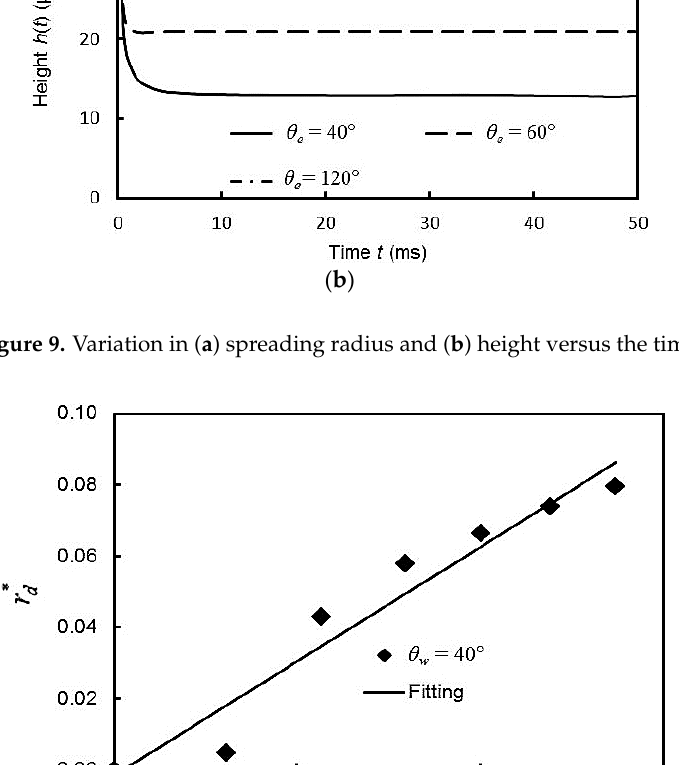
r versus * t . d √ r versus * t . Figure 10. Variation in dimensionless spreading radius r ∗ t ∗ versus d d